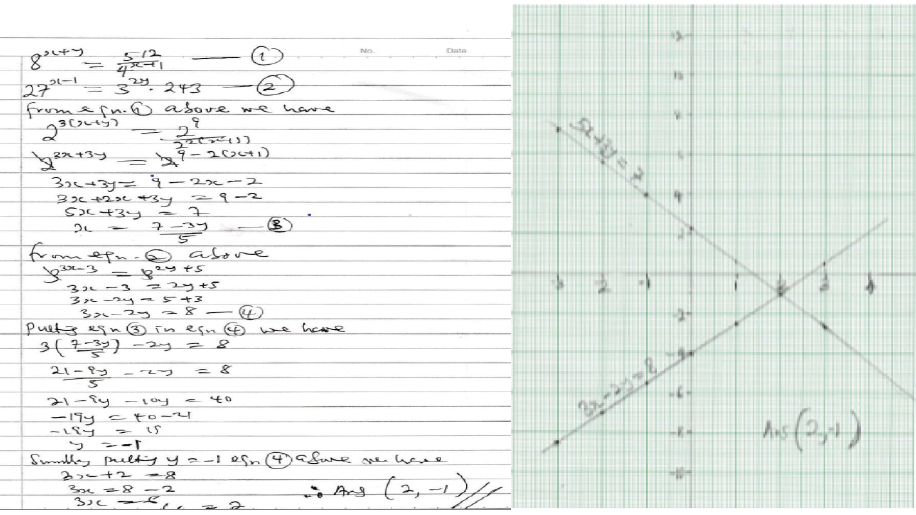
Figure 2. Students’ engagement with handwritten and